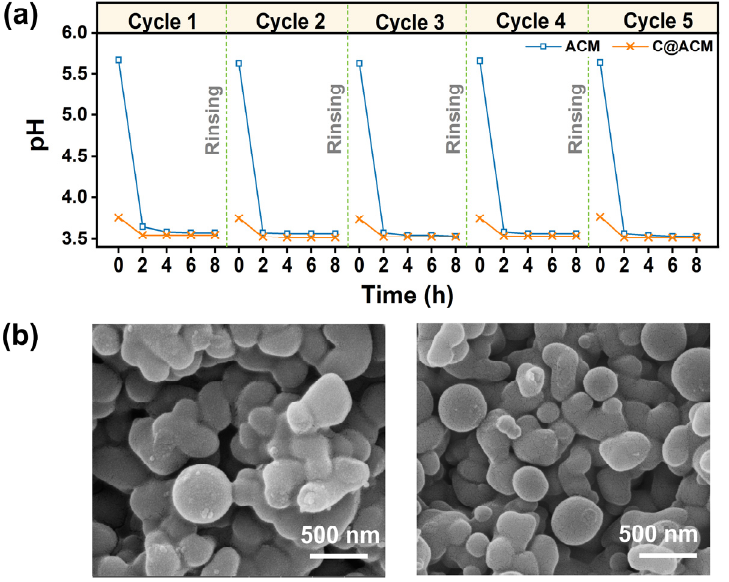
Figure 11. ( a ) the cyclic performance of ACM and C@ACM; ( b ) The SEM images of C@ACM before (the left one) and after (the right one) permeating the hydrochloric acid solution under 0.2 MPa.